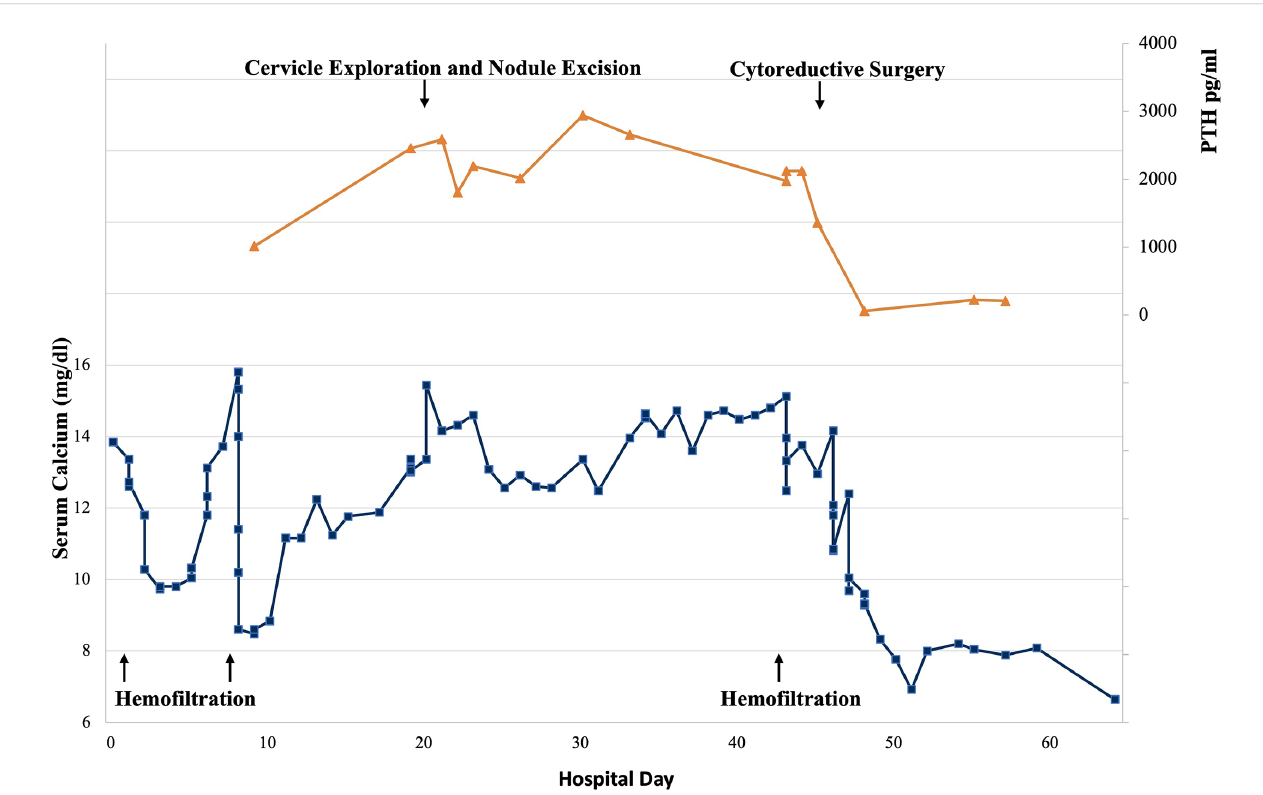
FIGURE 2 Serum calcium and parathyroid hormone (PTH) levels during patient ’ s hospitalization. Reference range of serum calcium: 8.52-10.80mg/dl, reference range of PTH: